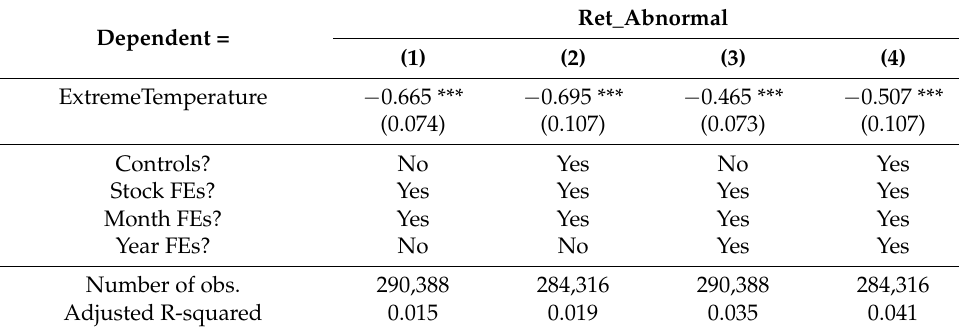
Table 10. Baseline regressions of excluding agriculture firms.